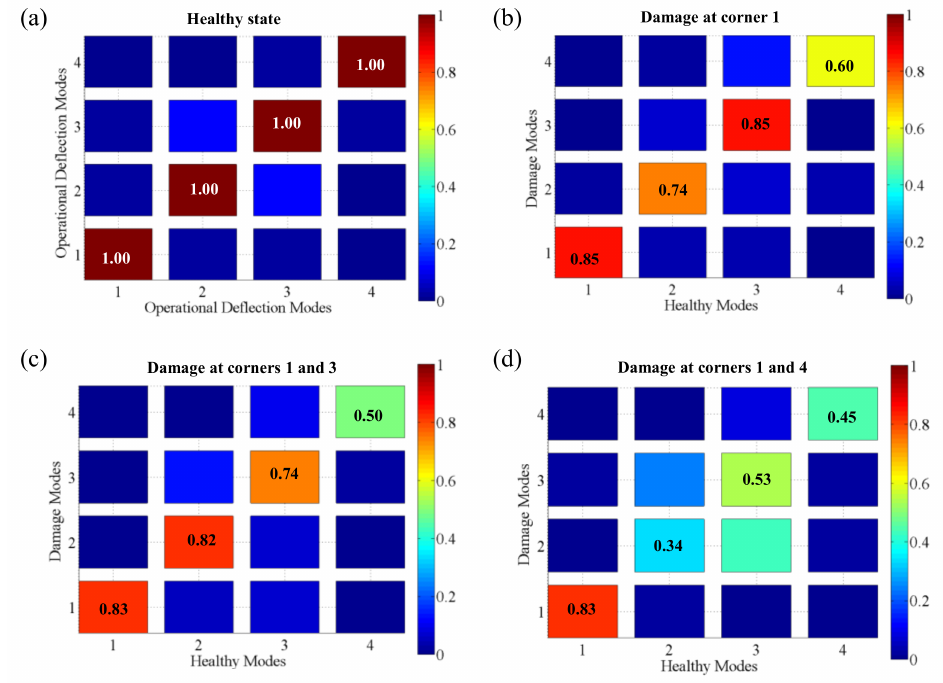
Figure 20. Calculated results of the MAC values: ( a ) self-comparison of a healthy state; comparison between a healthy state and damage states: ( b ) damage at corner #1, ( c ) damage at corners #1 and #3, and ( d ) damage at corners #1 and